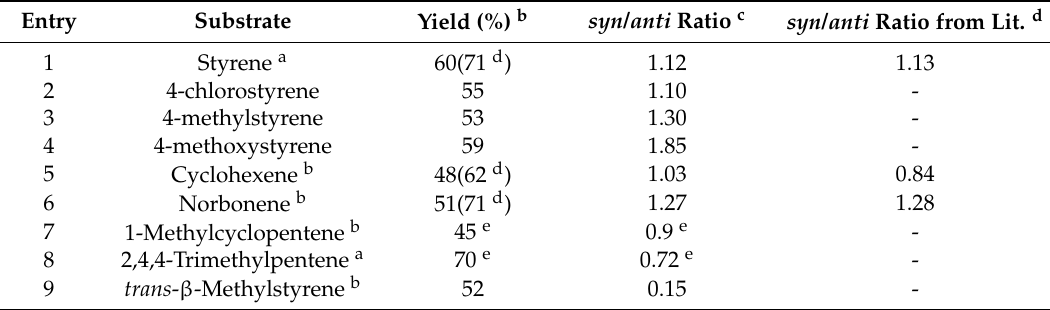
Table 1. Cyclopropanation of olefins catalyzed by 4 as catalyst compared with the data from previous